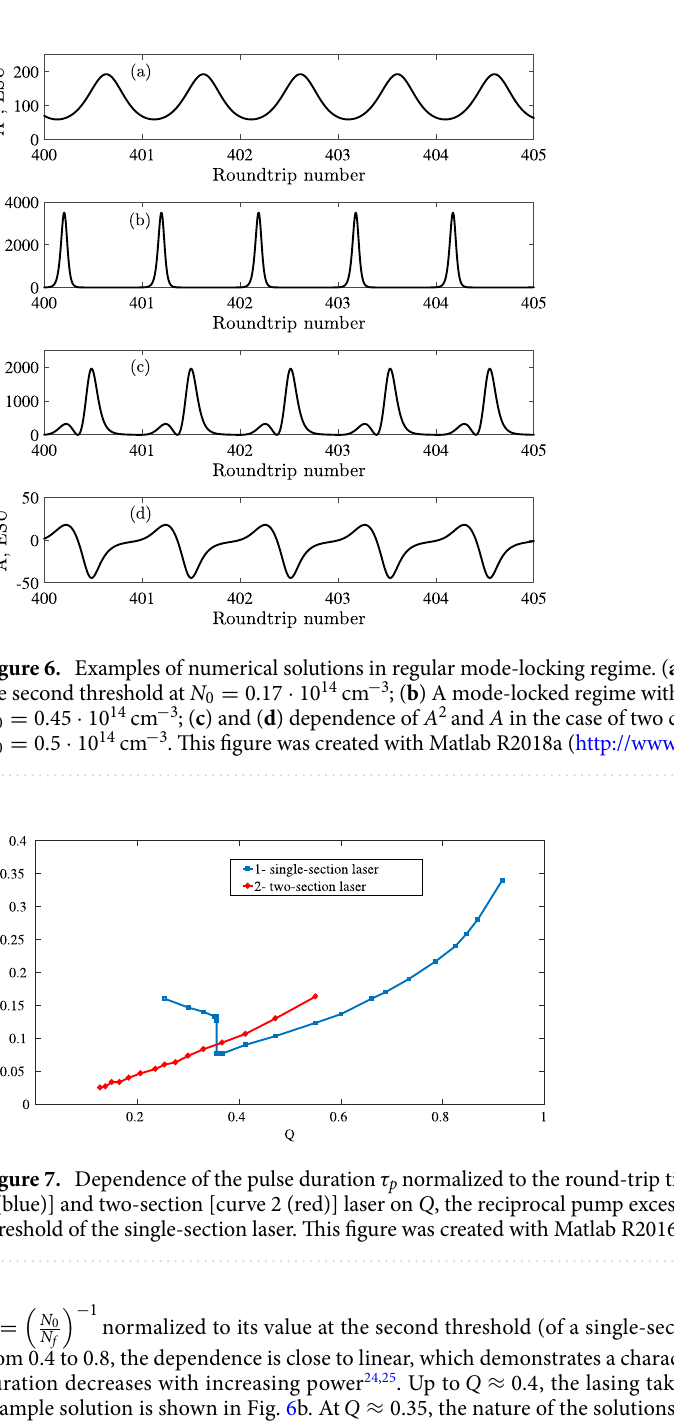
Figure 7. Dependence of the pulse duration τ p normalized to the round-trip time τ c for a single-section [curve 1 (blue)] and two-section [curve 2 (red)] laser on Q , the reciprocal pump excess, normalized to the second threshold of the single-section laser. This figure was created with Matlab R2016b (http://www.mathw